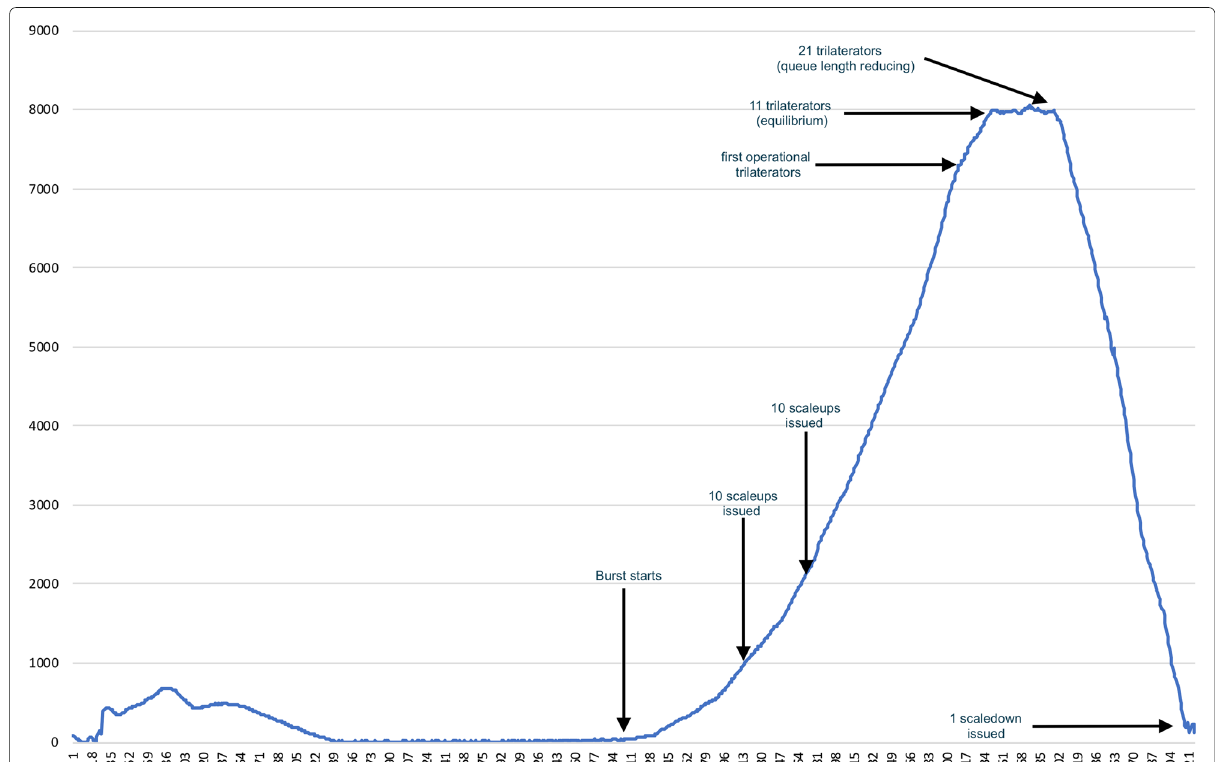
Fig. 7 Scale operations impact on load. Load balancer queue length fluctuation in an extreme